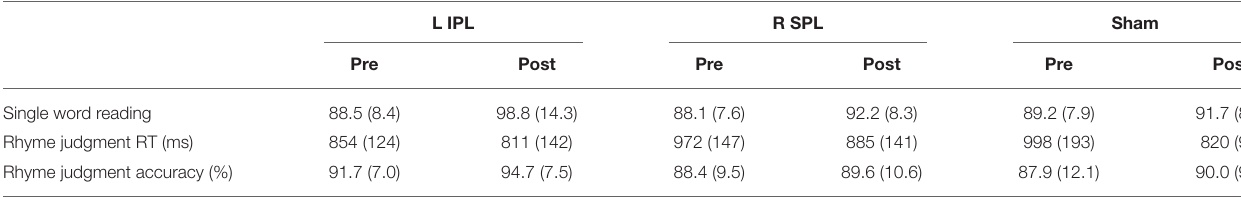
TABLE 2 | Mean (SD) on reading measures pre- and post-stimulation.